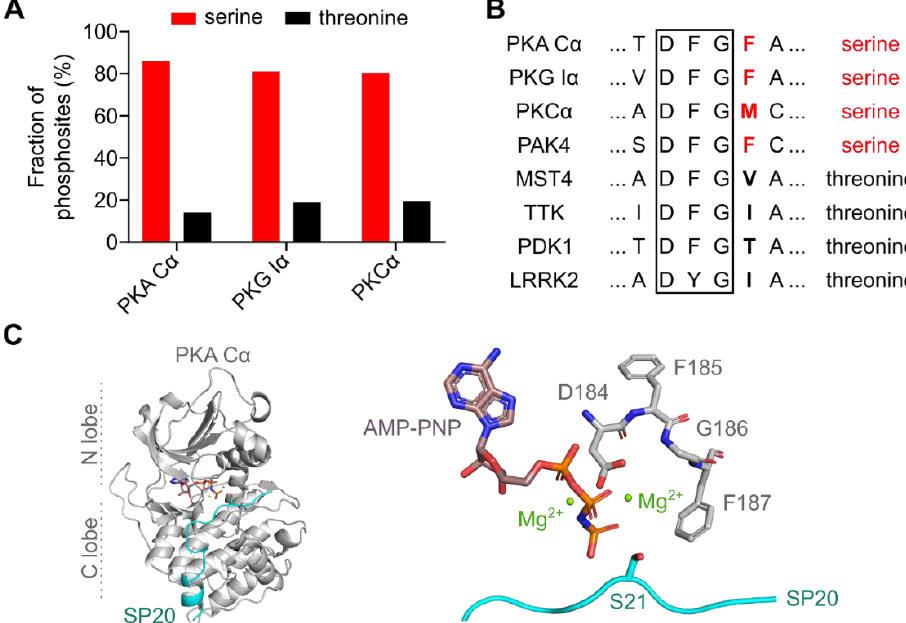
Figure 1. PKA prefers serine over threonine as a phosphoryl acceptor residue. ( A ) The AGC kinases PKA, PKG, and PKC are serine-specific. Bar diagram showing the fraction of annotated phosphosites for serine and threonine phosphoryl acceptors. Data were obtained from the PhosphoSitePlus ® database v6.5.9.1 [23]. ( B ) Alignment of the DFG motif (black box) and the DFG + 1 residues (bold letters) of human Ser / Thr protein kinases that prefer either serine (red) or threonine (black) as phosphoryl acceptor. The alignment was generated with Clustal Omega [24]. UniProt IDs: P17612 (PKA C α ); Q13976 (PKG I α ); P17252 (PKC α ); O96013 (PAK4); Q9P289 (MST4); P33981 (TTK); O15530 (PDK1); Q5S007 (LRRK2). (C) Crystal structure of the murine PKA Cα subunit with AMP-PNP, Mg 2+ ,